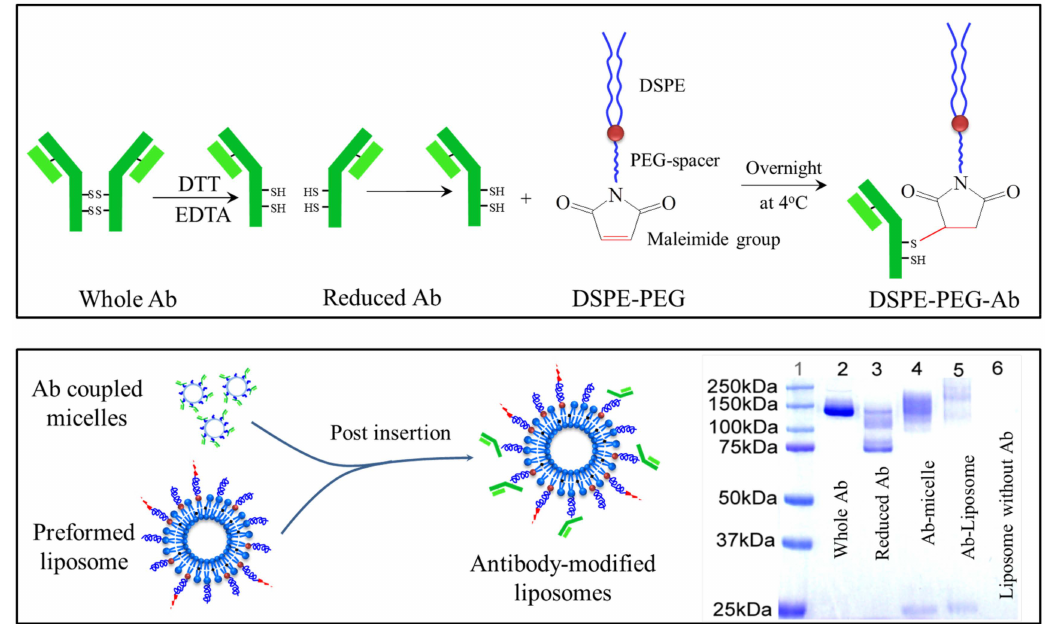
Figure 1. Schematic illustrations of DSPE-PEG-anti-CA IX Ab conjugation and the verification of the reduced antibody conjugation to micelles or liposomes by SDS-PAGE analysis with Coomassie blue